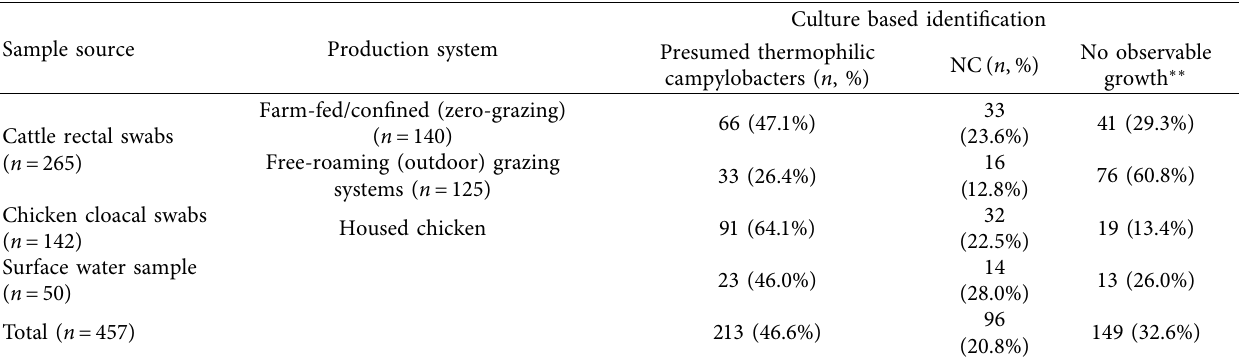
Figure 4: Agarose gel electrophoresis visualisation of PCR amplicons of 857 bp 16S rRNA gene for Campylobacter genus (wells 1–5), 600bp hipO gene for C. jejuni (wells 6–11), and 462bp ceuE gene for C. coli (wells 12–18). M: DNA ladder, where each Figure 3: Small Gram-negative short or curved rods to coccobacilli band represents of Campylobacter isolate ( × 1000) with characteristic “seagull” shaped curved rods. Table 2: Summary of culture-based results per individual sample source.